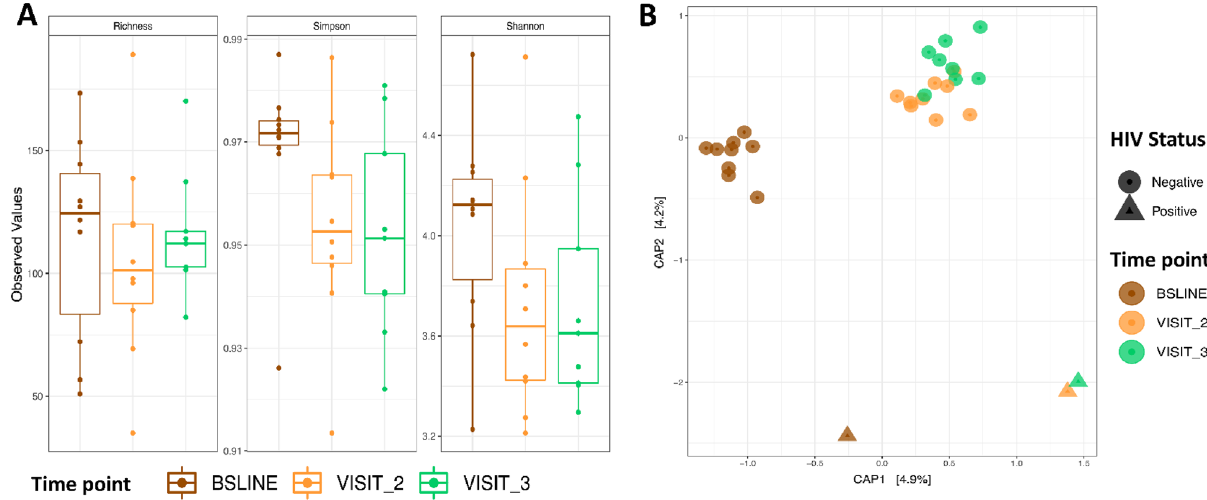
Figure 3. Microbial diversity analysis during first-line anti-TB treatment. ( A ) Depicts Alpha diversity for indices like Richness, Simpson and Shannon. ( B ) Depicts Beta diversity based on constrained ordination of the Bray–Curtis distances. Brown, orange and green represent months 0 (baseline), 2 and 5, respectively. The circular and triangular shapes in ( B ) denote HIV-negative and HIV-positive, respectively. Note this figure is based dataset C of Fig. 1 (n = 90 samples, 30 from each sampling